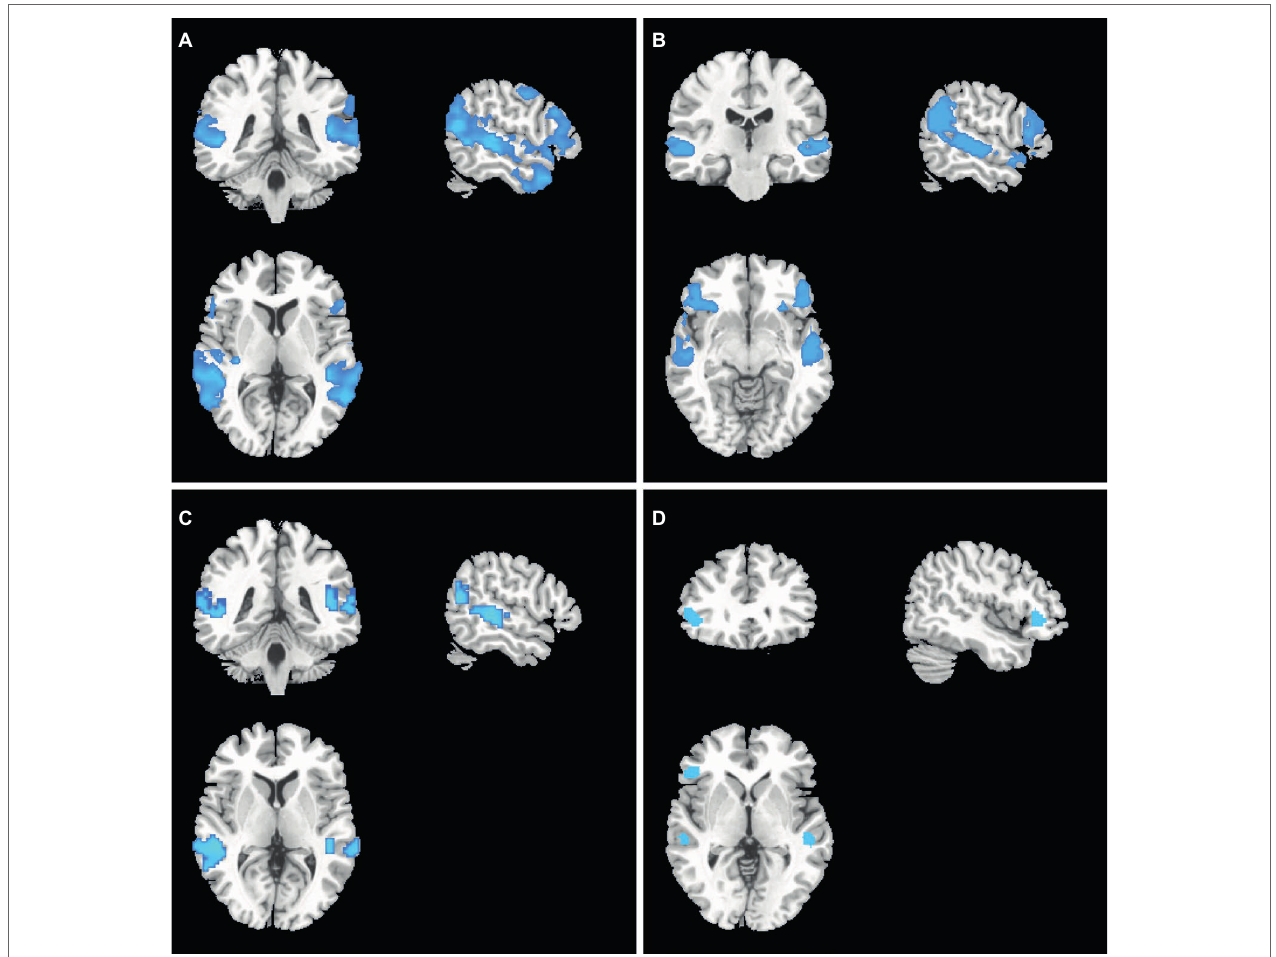
FIGURE 3 | gFCD and GMV differences before and after treatment in each